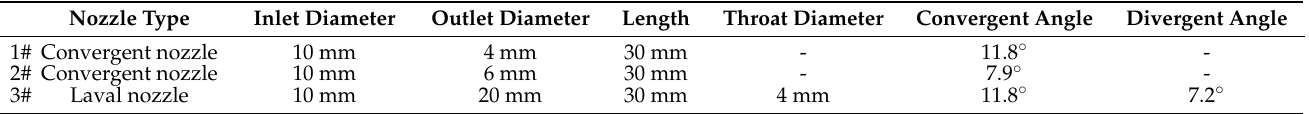
Table 2. Three nozzles’